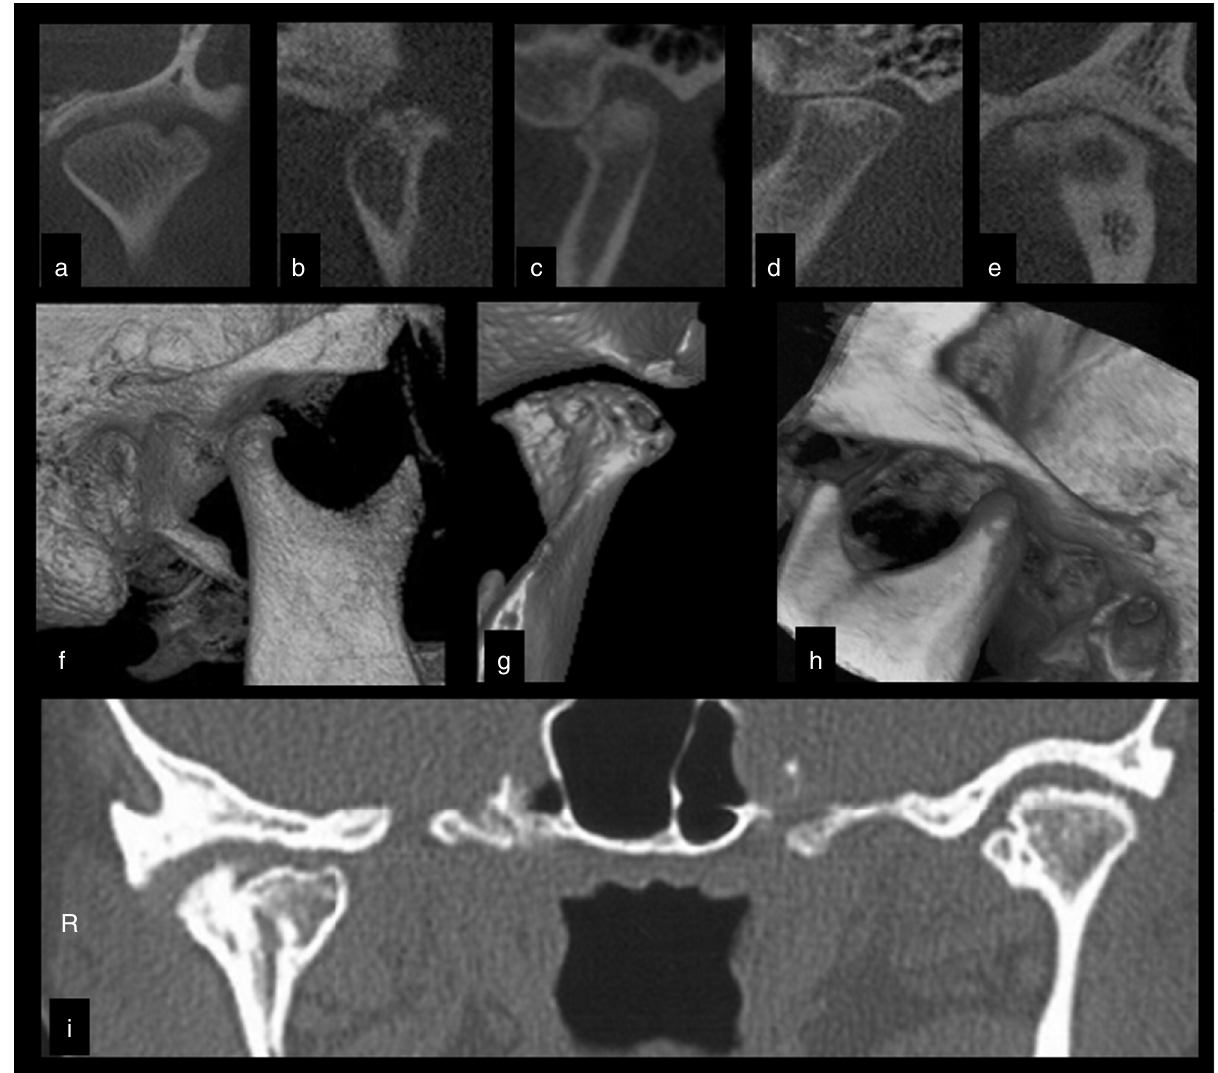
Figure 2 Cone-beam computed tomography (CBCT) assessment of different TMJs in the coronal (a, e) and parasagittal (b---d) views. (a) Coronal view showing extensive erosion. Note the presence of bone sclerosis, cortical irregularities, and osteophytic formation in (b), (c), and (e). The presence of subchondral cysts can be observed in (c) and (e). Advanced flattening of bone components and decreased joint space are recorded in (d). Advanced degenerative osteoarthritis alteration is observed in e. Three- dimensional reconstructions (f---h) show osteophytes (f, g), advanced erosion (g) and hyperexcursion of the mandibular condyle (h). (i) The coronal view of the right and left TMJ shows alteration of the mandibular condyle and hyperdense images in the joint spaces compatible with synovial